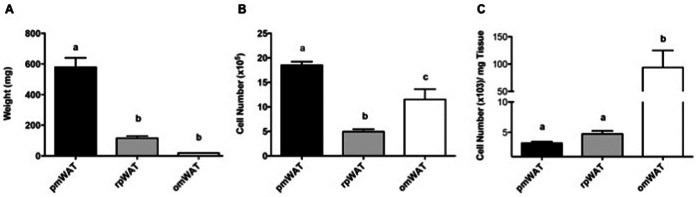
Adipose tissue depot weight and SVF cell counts.(A) Whole tissue weight. (B) Total number of SVF cells isolated from the digestion of each tissue. (C) Number of SVF cells isolated from the digestion of each milligram (mg) of adipose tissue. pmWAT; parametrial WAT, rpWAT; retroperitoneal WAT, omWAT; omental WAT. a,b,c Unlike letters indicate significance, p<0.05.